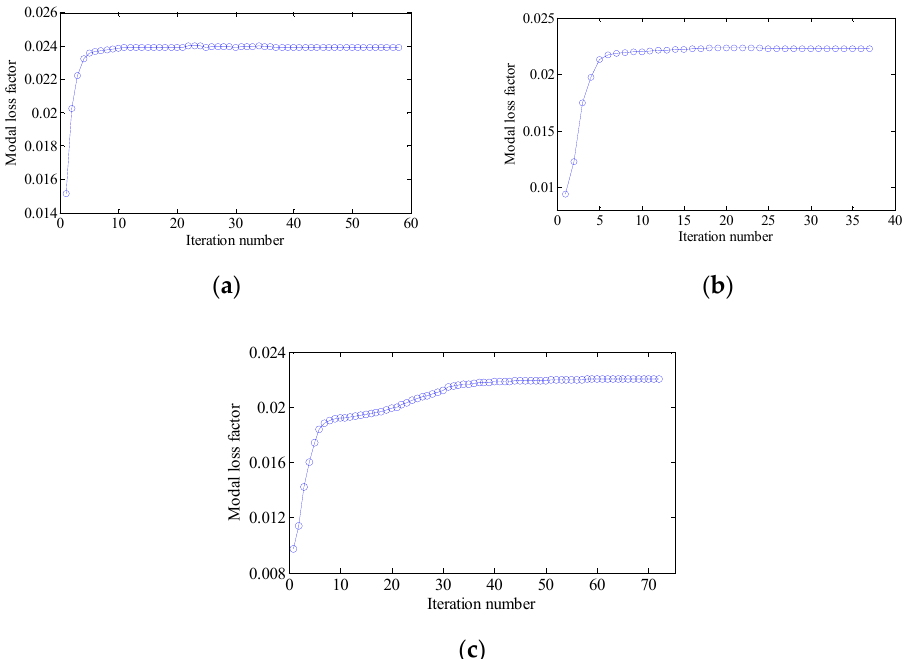
Figure 26. Iteration histories for maximizing the second modal loss factor: ( a ) Case 4: V MA